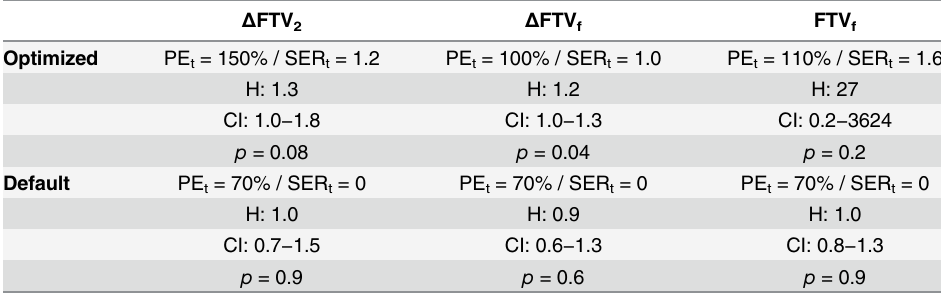
Table 3. Cox proportional hazards ratios at PE t /SER t with optimized association with RFS and at default setting for patients with HR+/HER2- breast cancer. Δ FTV Δ FTV 2 f FTV f Optimized PE t = 150% / SER t = 1.2 PE t = 100% / SER t = 1.0